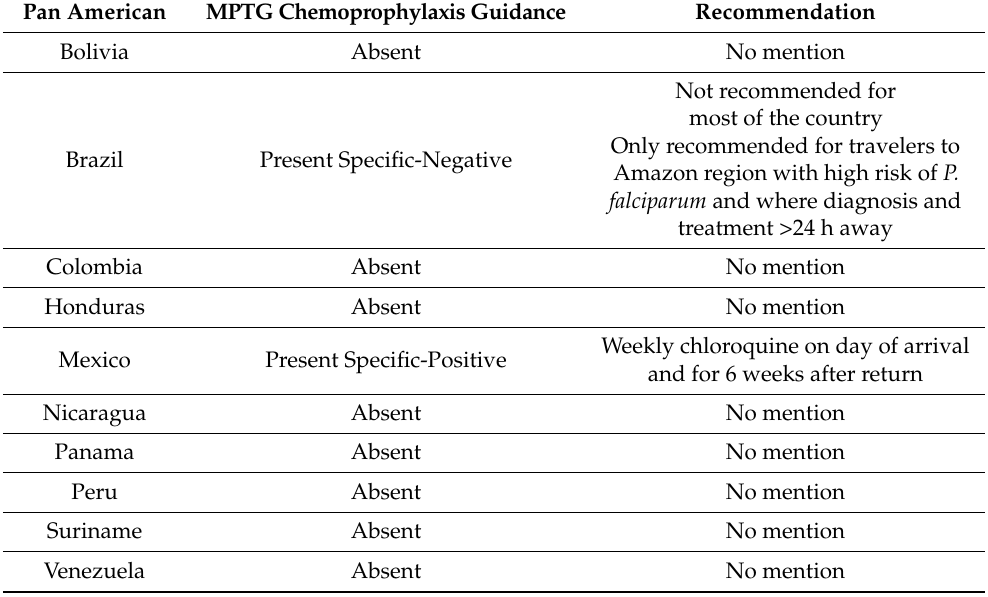
Table 5. Survey results for Pan American